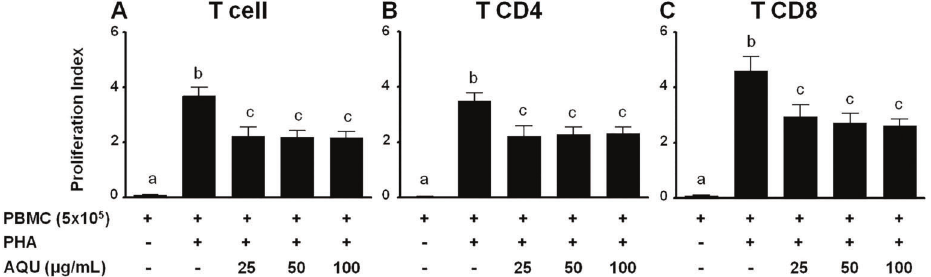
Figure 4. Antiproliferative effect of P. brasiliensis aqueous extract. Peripheral blood mononuclear cells (PBMCs, 5 (cid:2) 0 5 cells; n=6) labeled with carboxy fl uorescein succinimidyl ester (CFSE) were stimulated with phytohemagglutinin (PHA) in the absence or presence (25, 50, or 100 m g/mL) of P. brasiliensis aqueous extract (AQU). Non-stimulated cultures constituted the negative control (PBMC), and cultures stimulated with PHA in the absence of plant extract constituted the positive control. After 5 days, the proliferation index of lymphocytes ( A) , CD4 + T cells ( B ), and CD8 + T cells ( C ) was calculated by cytometry analysis. Data are reported as means ± SD. Different letters indicate signi fi cant differences (P p 0.05, ANOVA with Tukey post hoc